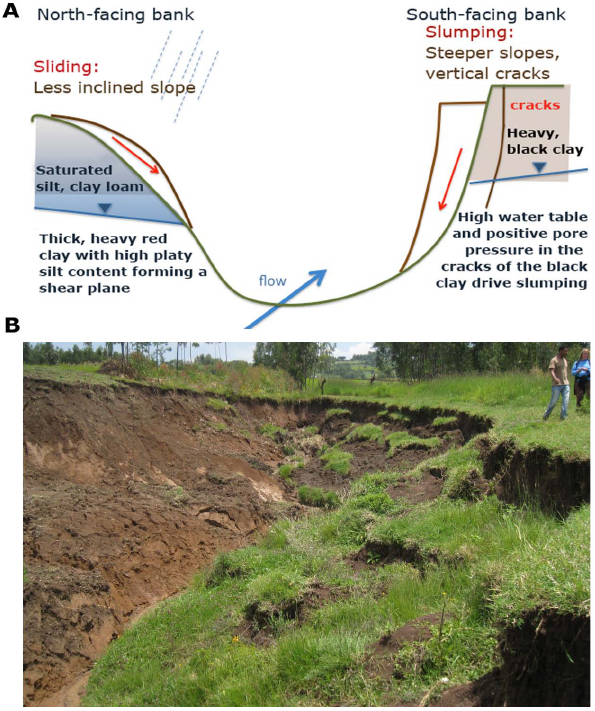
Fig. 6. (a) Schematic diagram of gully erosion processes and (b) example of gully bank failures.